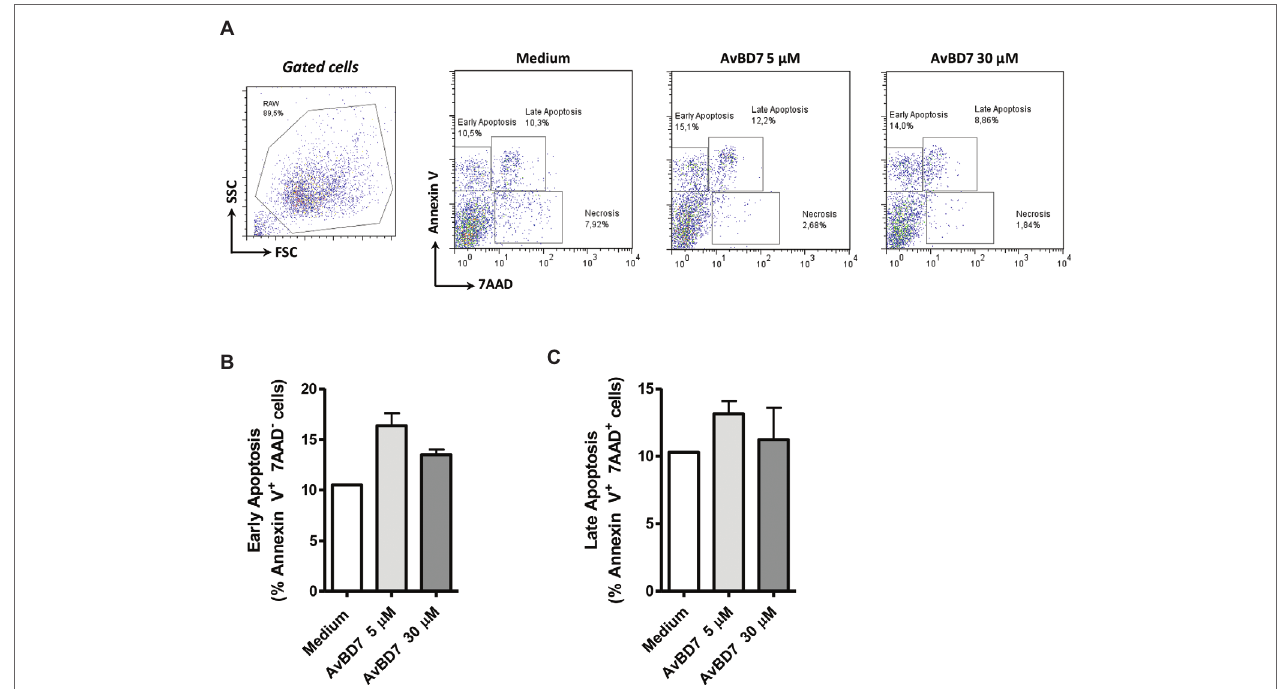
FIGURE 2 | Viability of murine macrophages following exposure to AvBD7. The RAW 264.7 cells were incubated with AvBD7 at 5 or 30 μM or with medium alone for 6 h, and were stained with annexin V-FITC or 7AAD. Parameters to measure cell death were early apoptosis (annexin V-FITC positive, 7AAD negative staining), late apoptosis (annexin V-FITC and 7AAD double positive staining) and necrosis (annexin V-FITC negative and 7AAD positive staining). (A) Flow cytometry dot plots showing the total gated cells (left plot) and the staining of the cells in different incubation conditions indicated above each of the right plots. Cells undergoing early apoptosis (top left), late apoptosis (top right) or necrosis (bottom right) are delineated on each plot. (B) and (C) Bar graphs showing the percentages of early (B) and late (C) apoptotic cells following incubation in conditions indicated below each bar ( n =